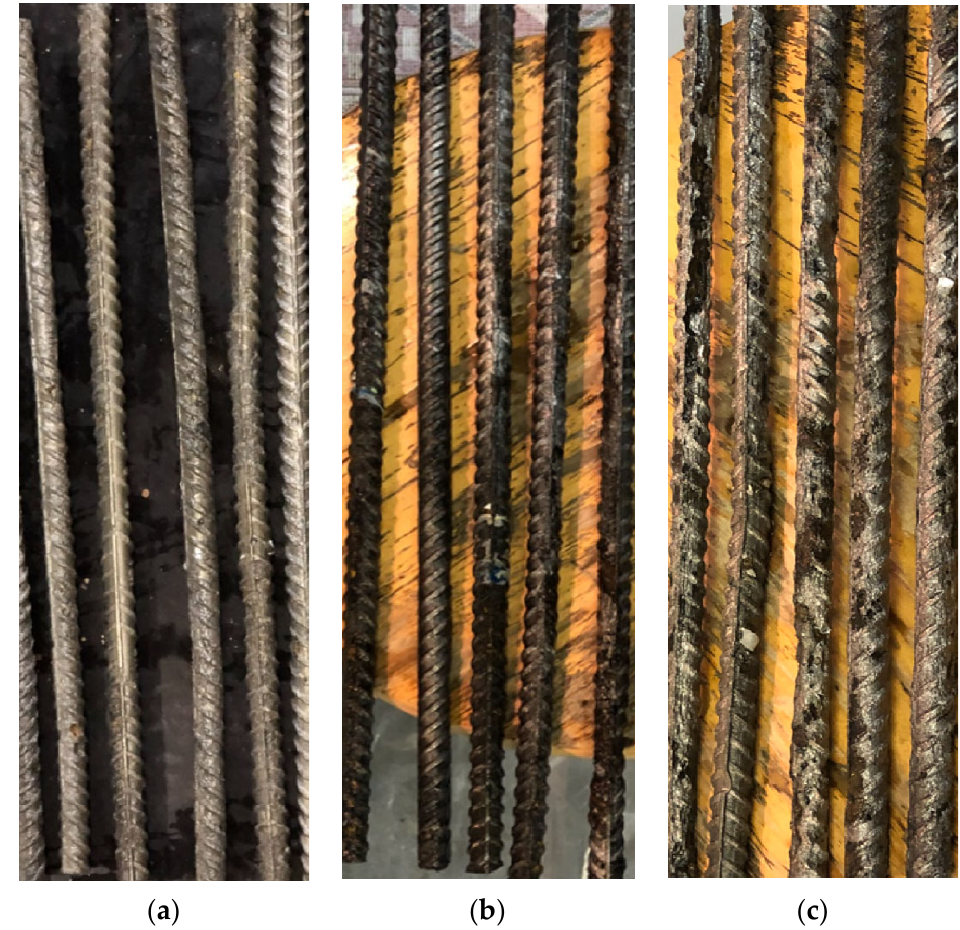
Figure 11. Corroded steel bars extracted from: ( a ) beam A , ( b ) beam B , and ( c ) beam C .